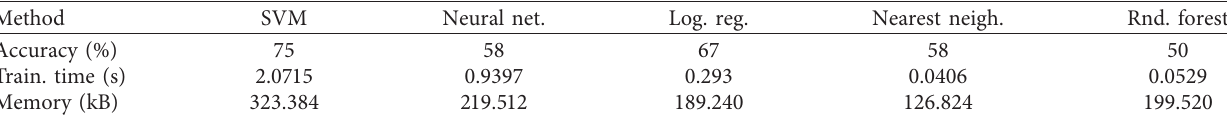
Table 2: Comparison of ML methods.